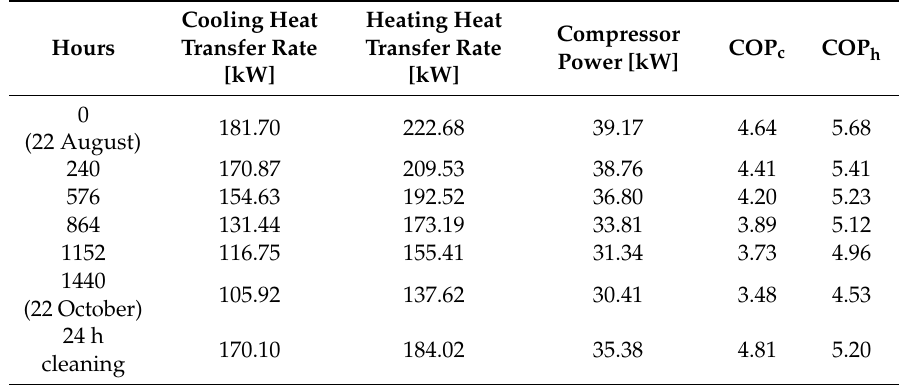
Table 4. Summary of heat transfer rate, compressor power, and COP according to operating